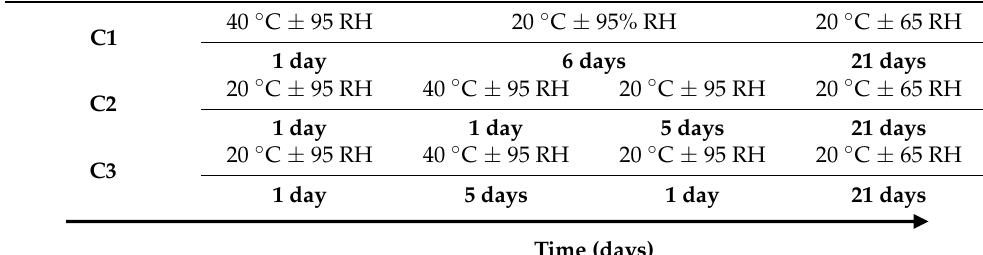
Table 2. The examined curing conditions.